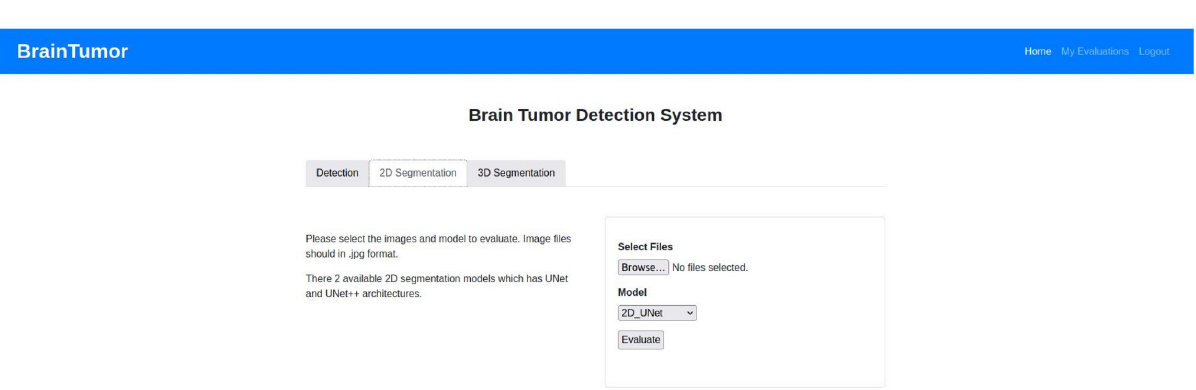
Table 9 and Fig 24 show performance evaluations for the 2D and 3D MRI segmentations with U-Net and U-Net++ models. The 2D segmentations achieved more than 84% and 61% training Dice score and validation Dice scores respectively. The prediction Dice scores on the test dataset were higher than the validation scores and varied from 80% to almost 82%. The 3D segmentation models achieved higher Dice scores for training, validation and testing data and all scores were higher than 90% attaining more than 96%. The 3D U-Net models achieved almost same to 2% higher Dice scores for the test datasets compared to the training and valida- tion whereas the 3D U-Net++ models had almost no difference between training, validation and testing data. The results showed that the U-Net models performed slightly better in tumor segmentation than the U-Net++ models for both 2D and 3D data. Although the training and validation Dice scores for most cases were very similar and the prediction Dice scores showed the differences between the models more clearly for both 2D and 3D data, the Dice scores for all implemented models were comparable to DL-based brain tumor segmentation. Fig 25 shows a more comprehensive plot diagram based on the average Dice scores of the test data